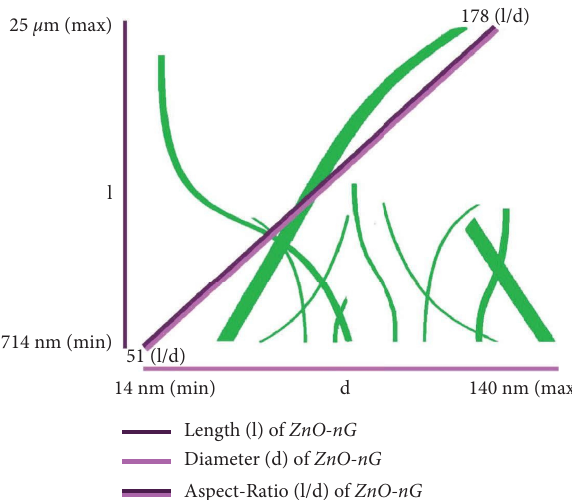
Figure 6: Comparative chart showing length (l), diameter (d), and aspect-ratio (l/d) of long grass like one-dimensionalG-ZnO NPs crystals produced by extending the incubation period while keeping the ambient temperature line